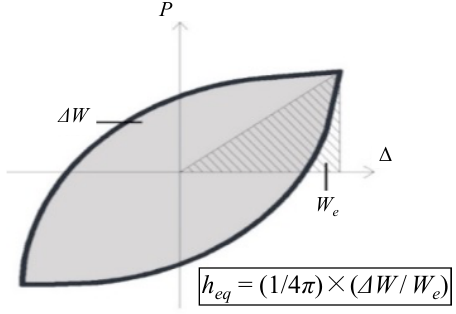
Figure 9. Ductility coe ffi cient.